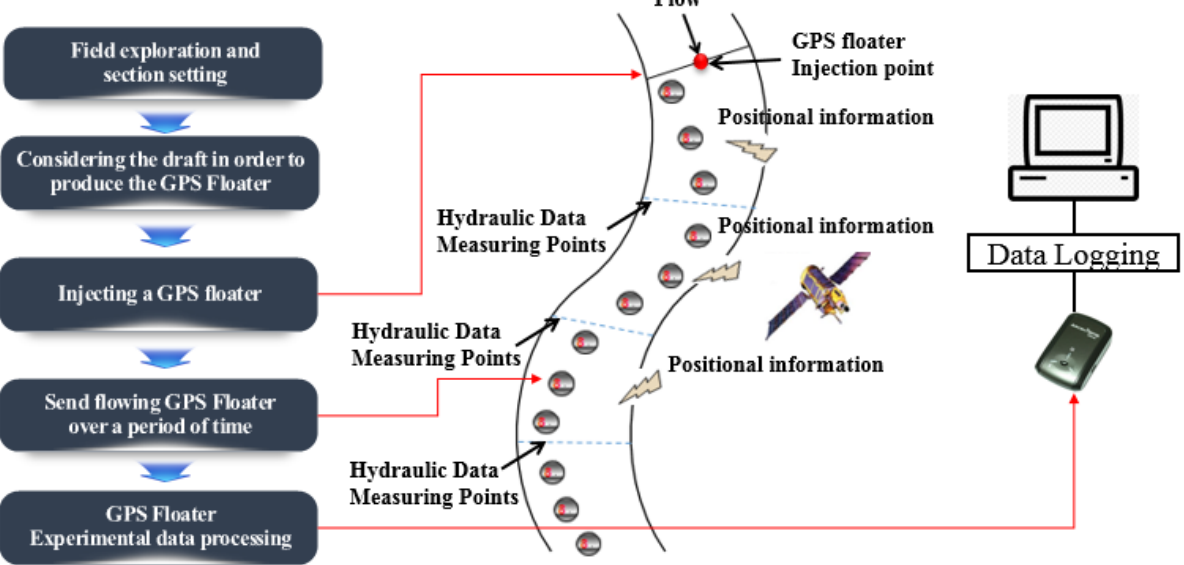
Figure 4. Standard procedure of GPS drifter field experiments.